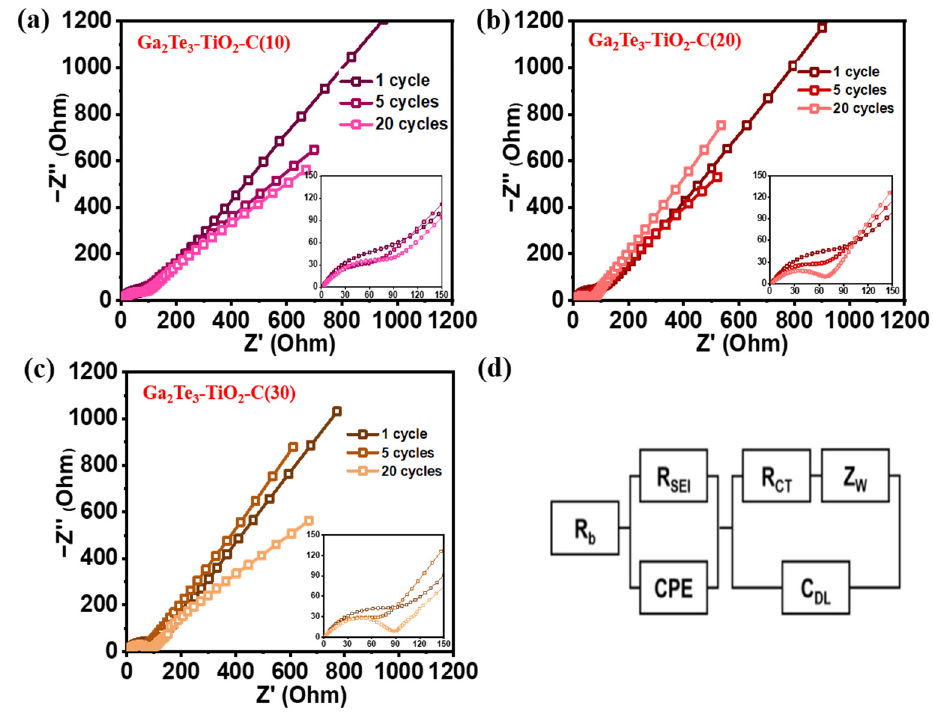
Figure 6. EIS-based Nyquist plots for ( a ) Ga 2 Te 3 -TiO 2 -C (10%), ( b ) Ga 2 Te 3 -TiO 2 -C (20%), ( c ) Ga 2 Te 3 - TiO 2 -C (30%) after 1, 5, and 20 cycles; and ( d ) equivalent circuit. TiO 2 -C (30%) after 1, 5, and 20 cycles; and ( d ) equivalent circuit. The electrochemical Li-storage behaviors were determined from the above The electrochemical Li-storage behaviors were determined from the above results.